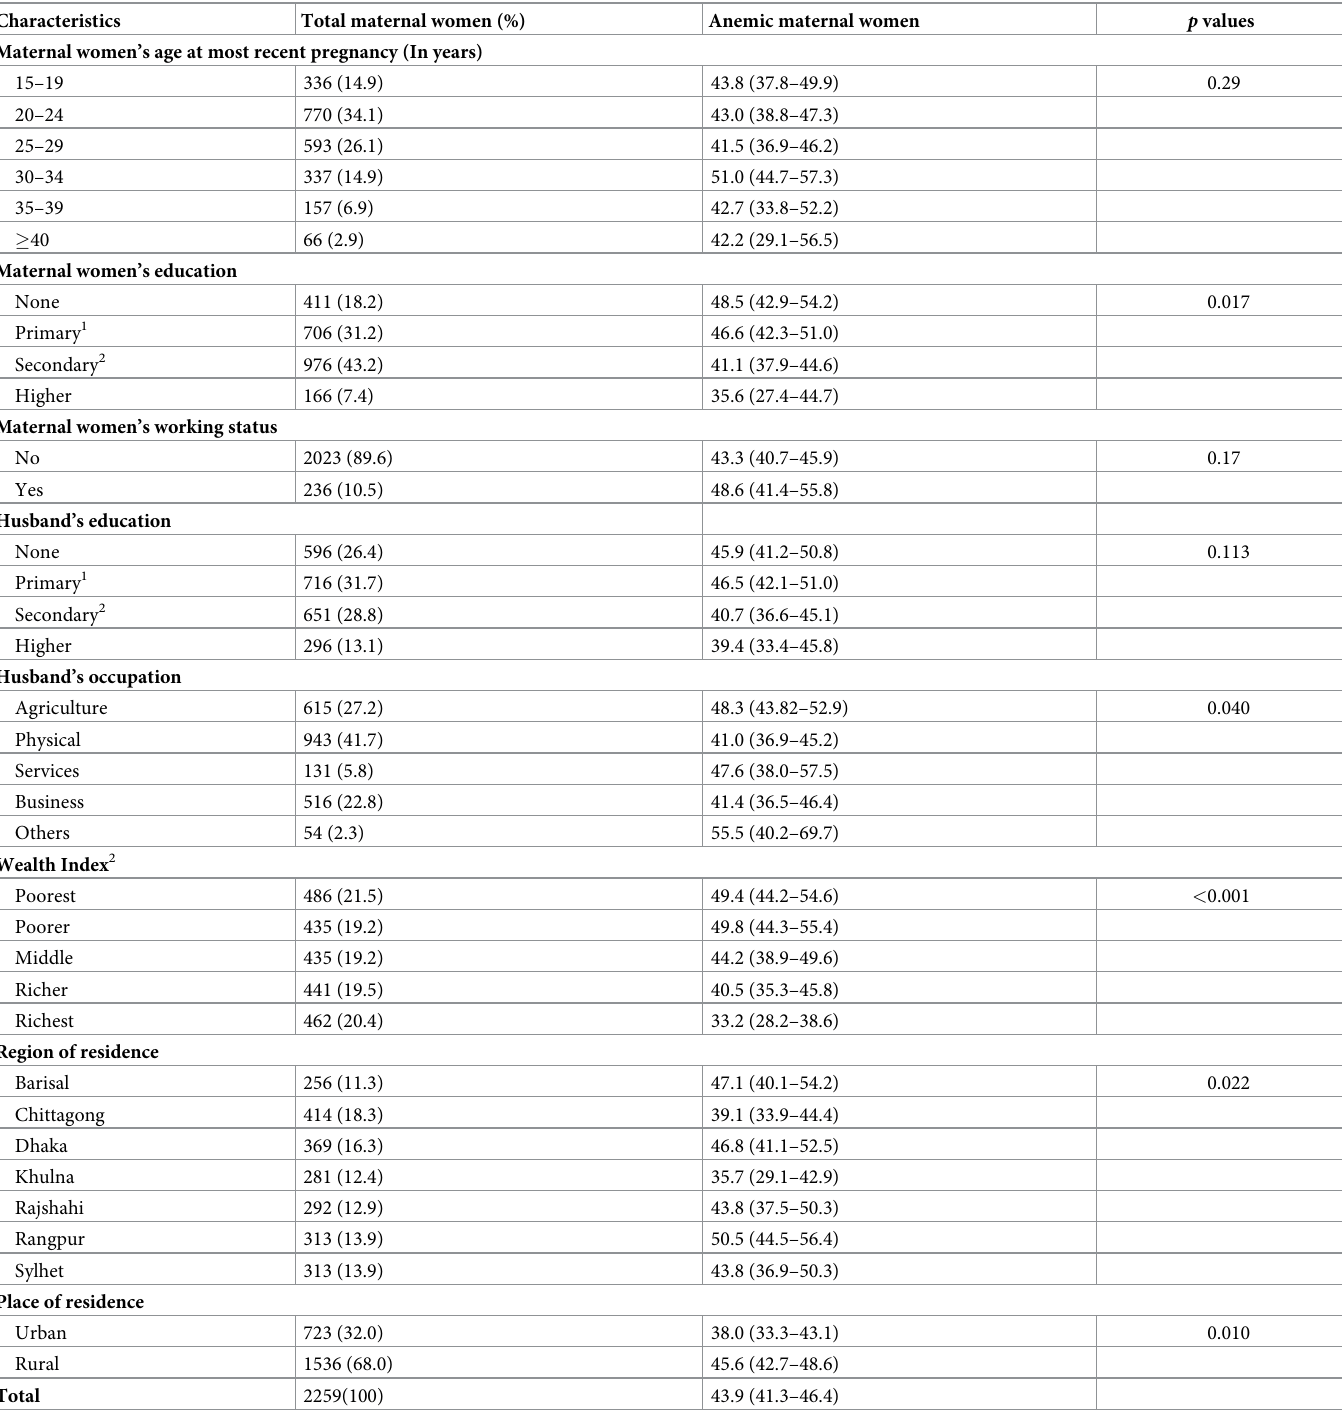
Table 2. Distribution of the respondents by some selected socio-economic characteristics and anemia, (N = 2259).